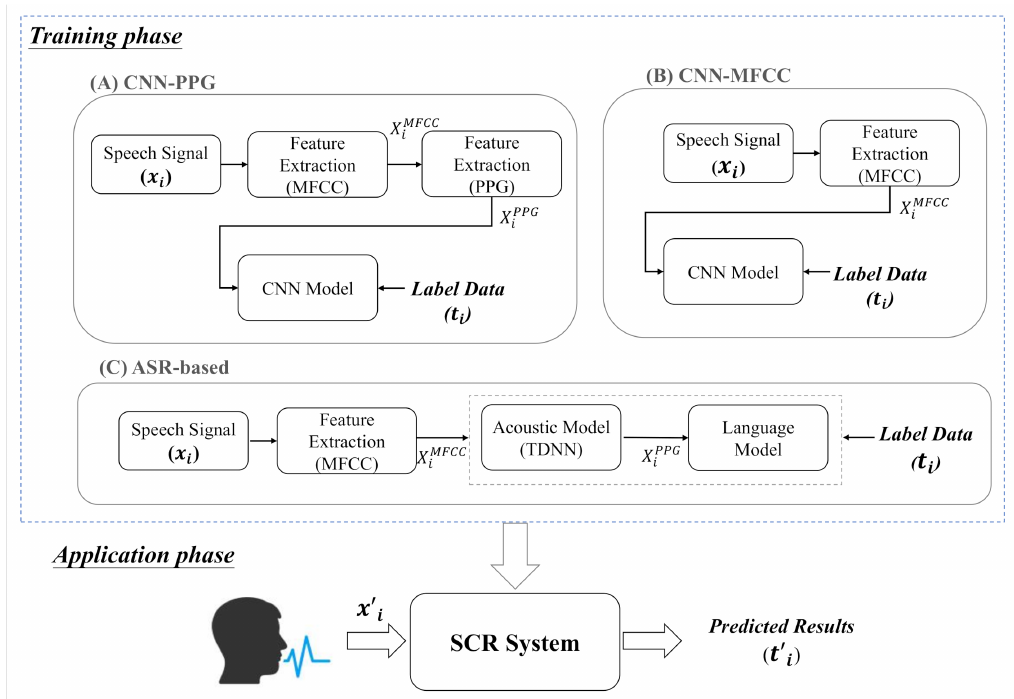
Figure 1. Three well-known speech command recognition (SCR) systems: ( A ) convolution neural network with Mel- frequency cepstral coefficient (CNN–MFCC), ( B ) convolution neural network with a phonetic posteriorgram (CNN–PPG) and ( C ) automatic speech recognition